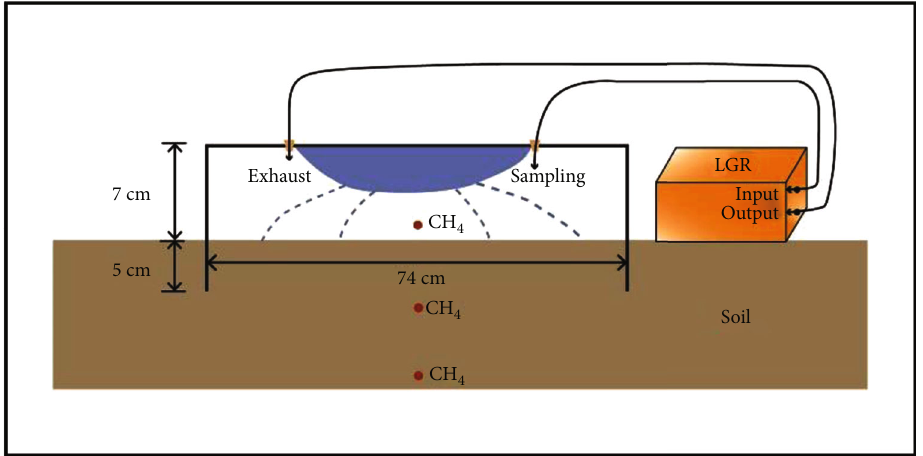
Figure 10: Scheme of CH